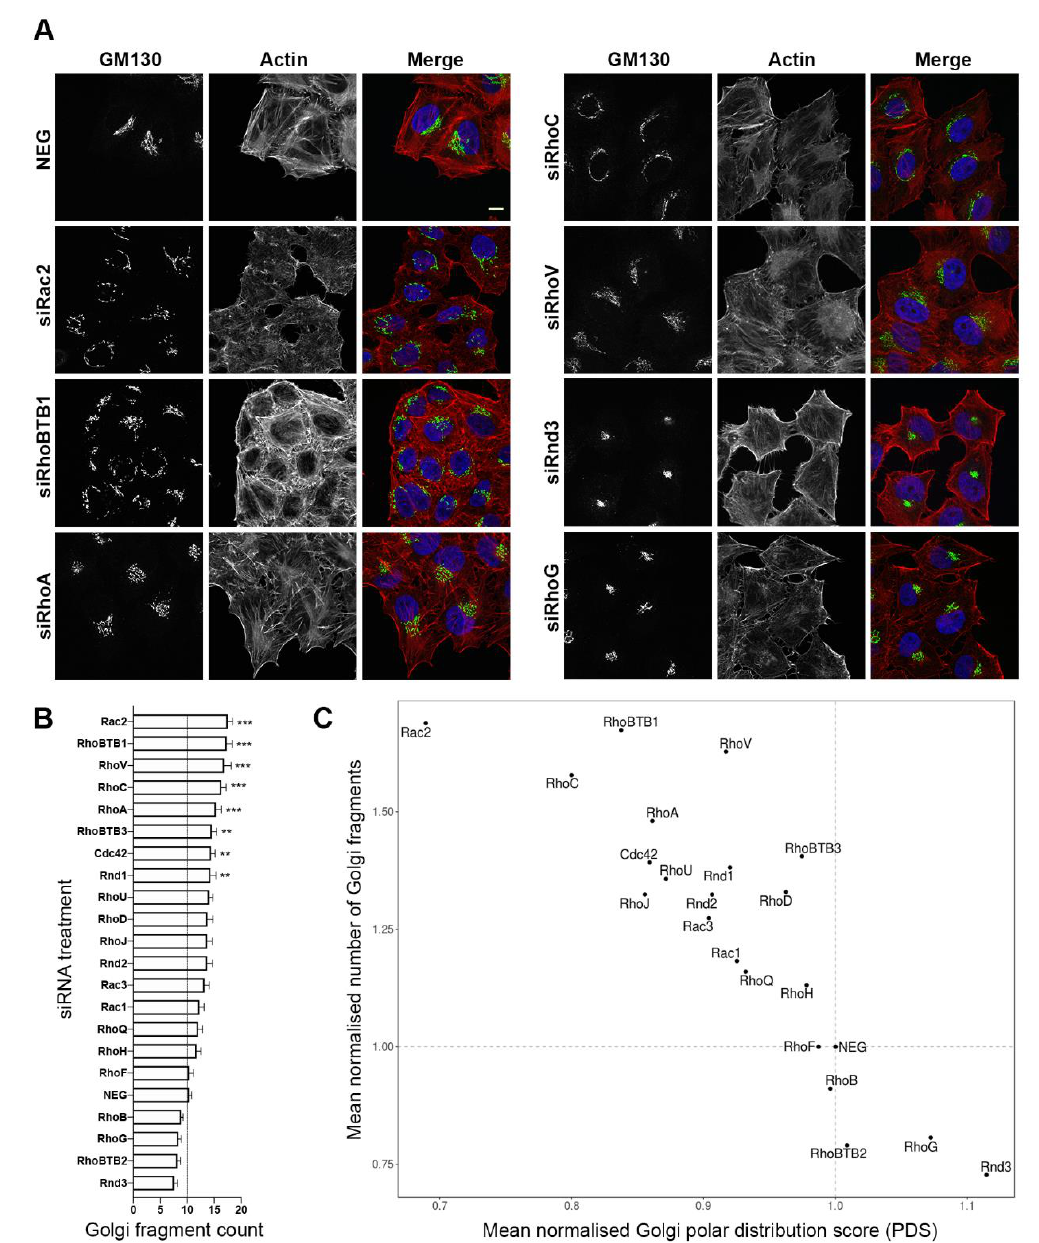
Figure 1. Depletion of several Rho GTPase proteins affects Golgi complex morphology. ( A ) Representative images of HeLa Kyoto cells treated with either non-silencing (NEG) control siRNAs, or siRNA pools targeting specific Rho family GTPases. The cis -Golgi is shown in green (marked by GM130), the nuclei are shown in blue, and actin is in red (marked by phalloidin). Bar represents 10 μm. ( B ) Graph showing numbers of detected Golgi fragments in cells following siRNA treatment as indicated. *** p < 0.001 and ** p < 0.01 compared with NEG control cells. ( C ) Scatter plot showing the mean normalised Golgi complex polar distribution score on the x -axis and the mean normalised number of Golgi fragments on the y -axis following Rho GTPase depletion for 48 h. n = 3 independent experiments, with a total of at least 70 cells analysed per siRNA